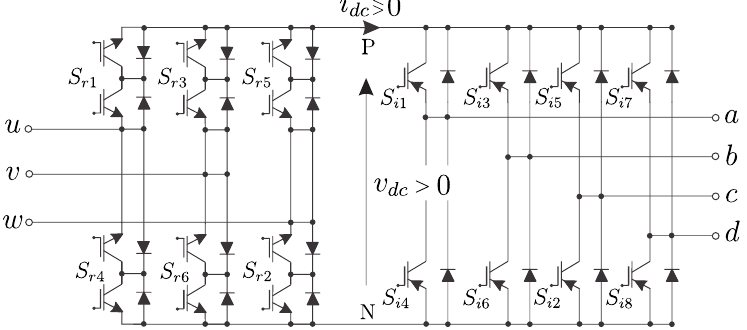
Figure 22. Four-Leg indirect matrix